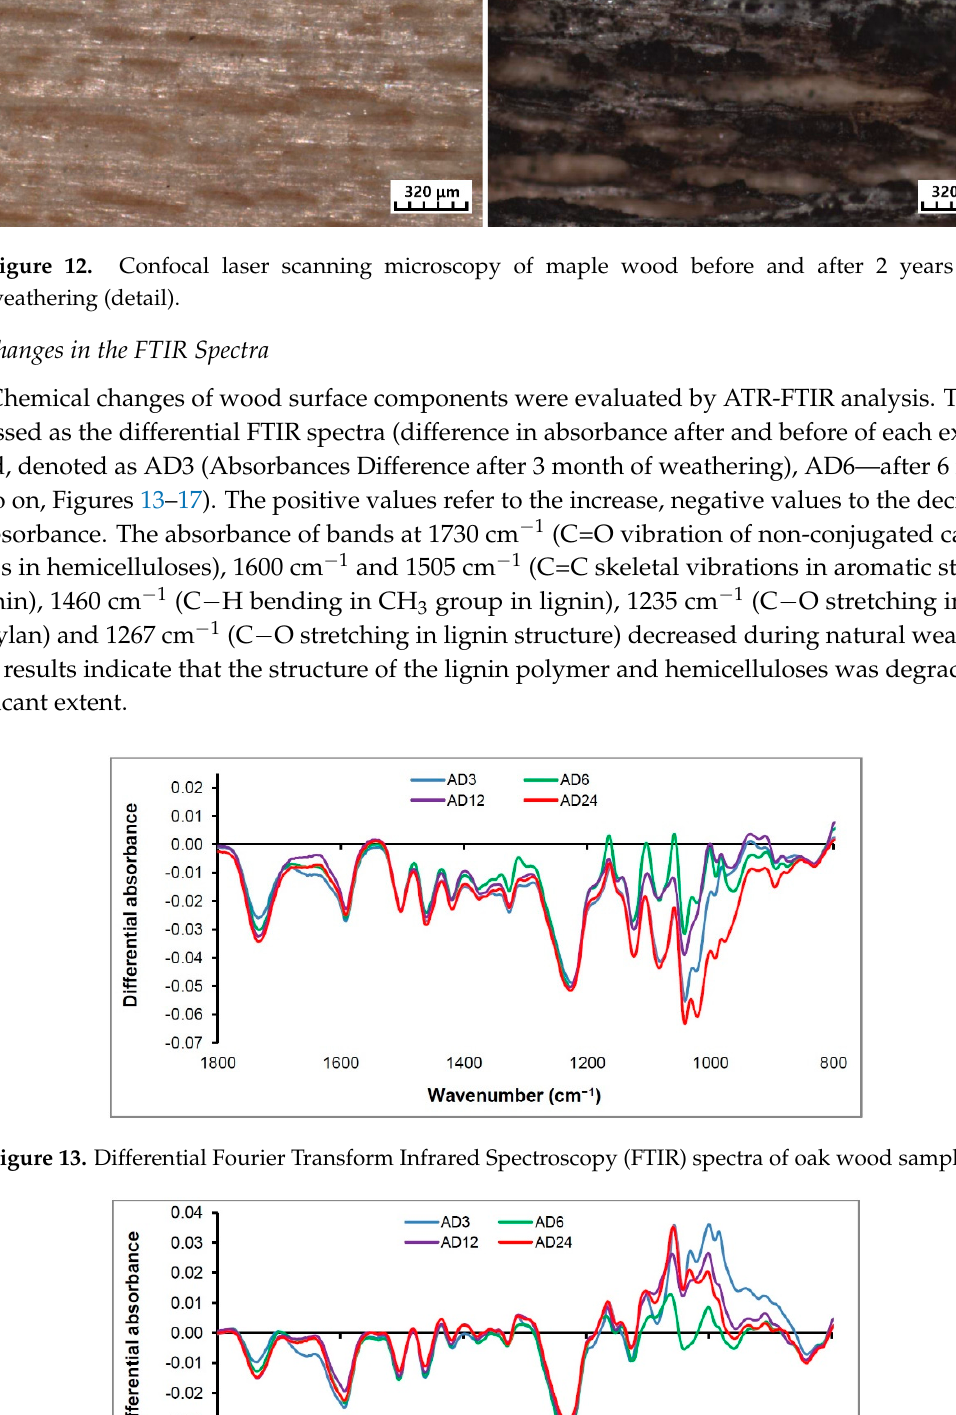
Figure 11. Confocal laser scanning microscopy of alder wood before and after 2 years of weathering (detail).